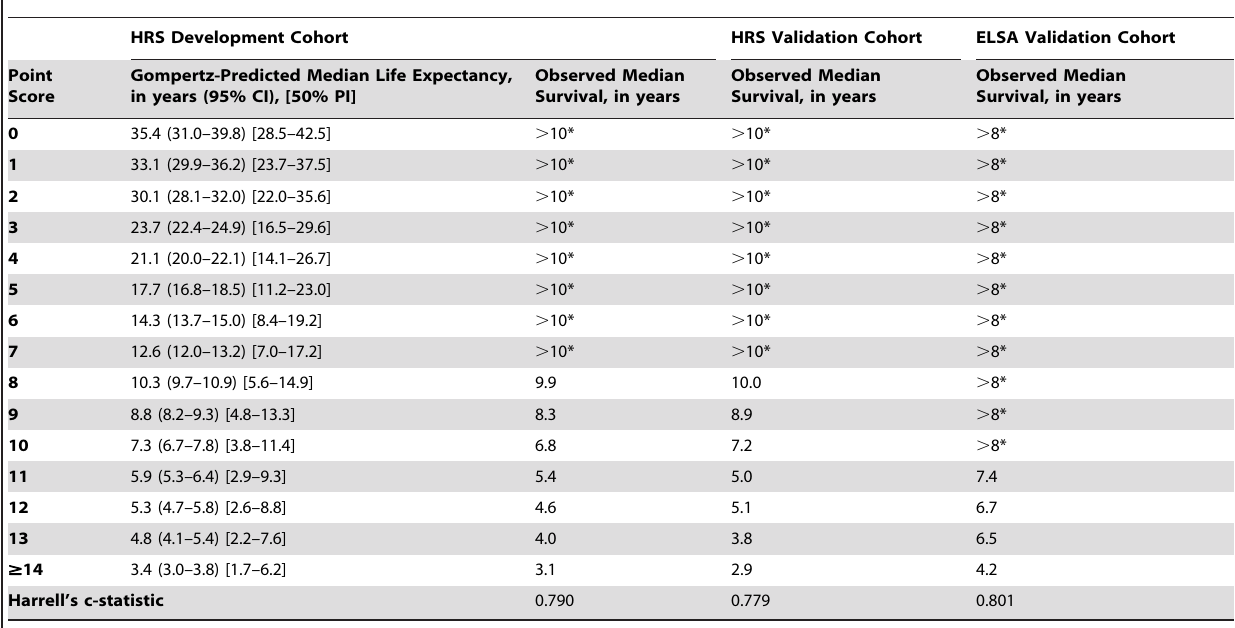
Table 2. Validation of Gompertz-Predicted Median Life Expectancy by Risk Points.